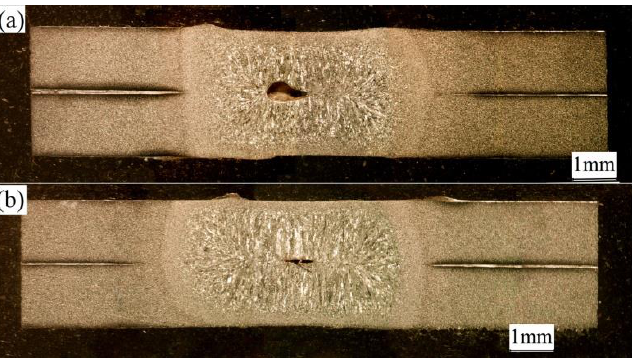
Figure 9. The geometric properties of the welded joints in the electrode failure process: ( a ) the 528th weld; ( b ) the 616th weld.